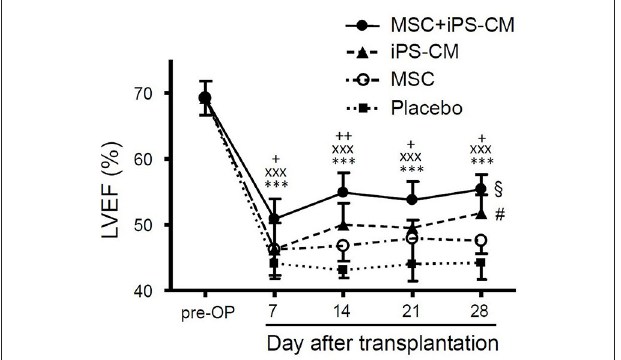
FIGURE 5 | Assessment of cardiac function from weekly cardiac MRI scans after induction of MI. LVEF was determined in healthy animals pre-operatively and at weekly intervals after MI and cell transplantation in groups that received PBS ( n = 9), MSC ( n = 9), iPS-CM ( n = 8), or iPS-CM + MSC ( n = 8). Statistically significant results for iPS-CM + MSC group: *** p < 0.001 vs. placebo, xxx p < 0.001 vs. MSC, + / ++ p < 0.05/0.01 vs. iPS-CM; § p < 0.05: iPS-CM + MSC on day 1 vs. iPS-CM + MSC on day 7; # p < 0.05: for iPS-CM on day 1 vs. iPS-CM on day 7 (all one-way ANOVA with the